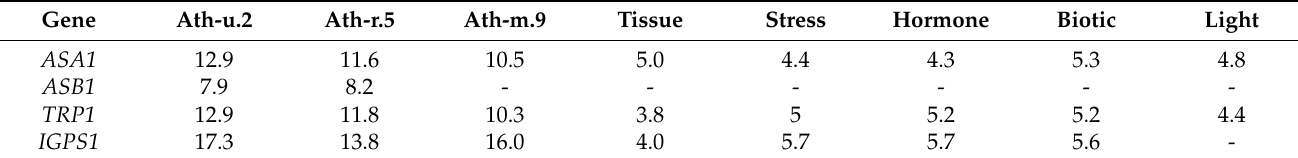
Table 3. Coexpression of TSA with trp biosynthesis genes in the chorismic acid pathway